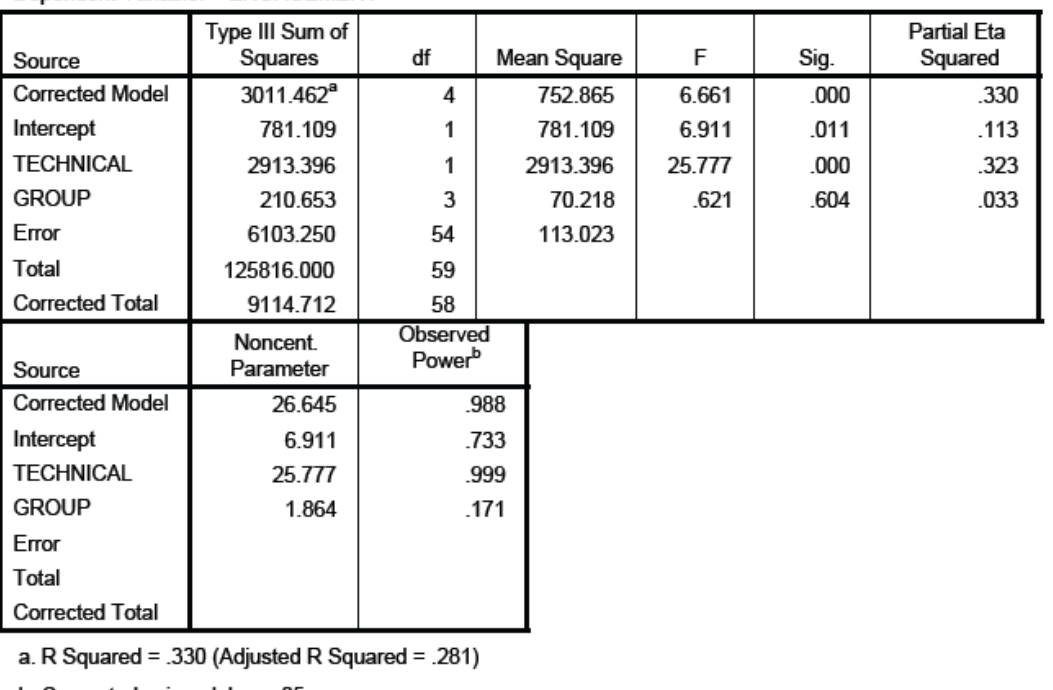
Figure B.5. ANCOVA analysing engagement levels between the four groups of participants using data adjusted for technical performance for participants who correctly indicated their